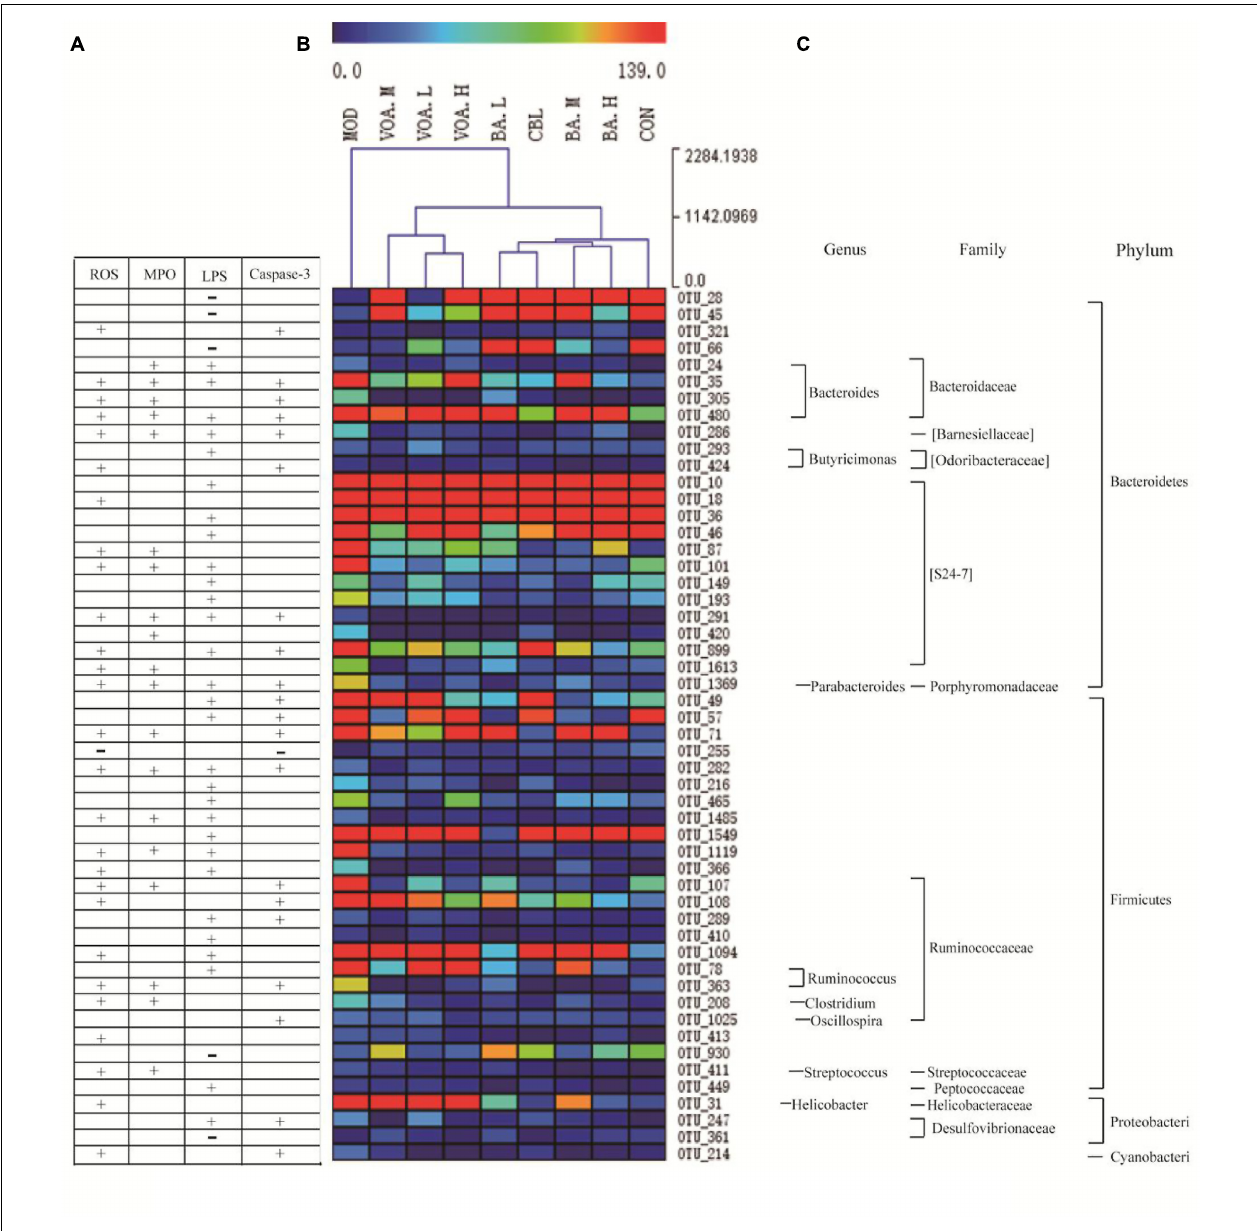
FIGURE 10 | Correlation between 52 key OTUs and intestinal mucositis index. These key OTUs were significantly altered after VOA and BA treatments, and were correlated with changes in ROS, MPO, LPS, and caspase-3 (A) . Clustering analysis of OTU (B) and represented bacteria taxa information (genus, family, and phylum) of 52 key OTUs (C) . “+” Indicates a positive correlation with ROS, MPO, LPS, and caspase-3, and “–” indicates a negative correlation.